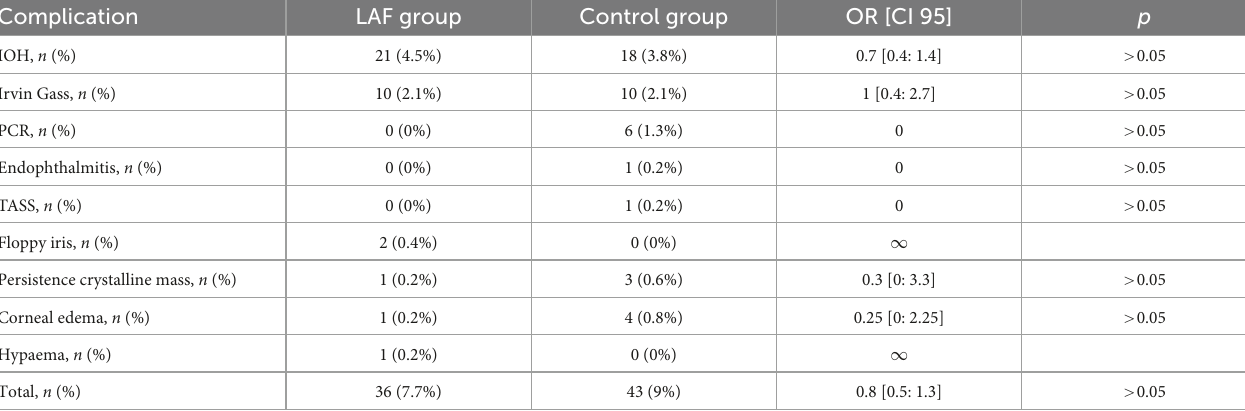
TABLE 2 Perioperative and postoperative complications in two